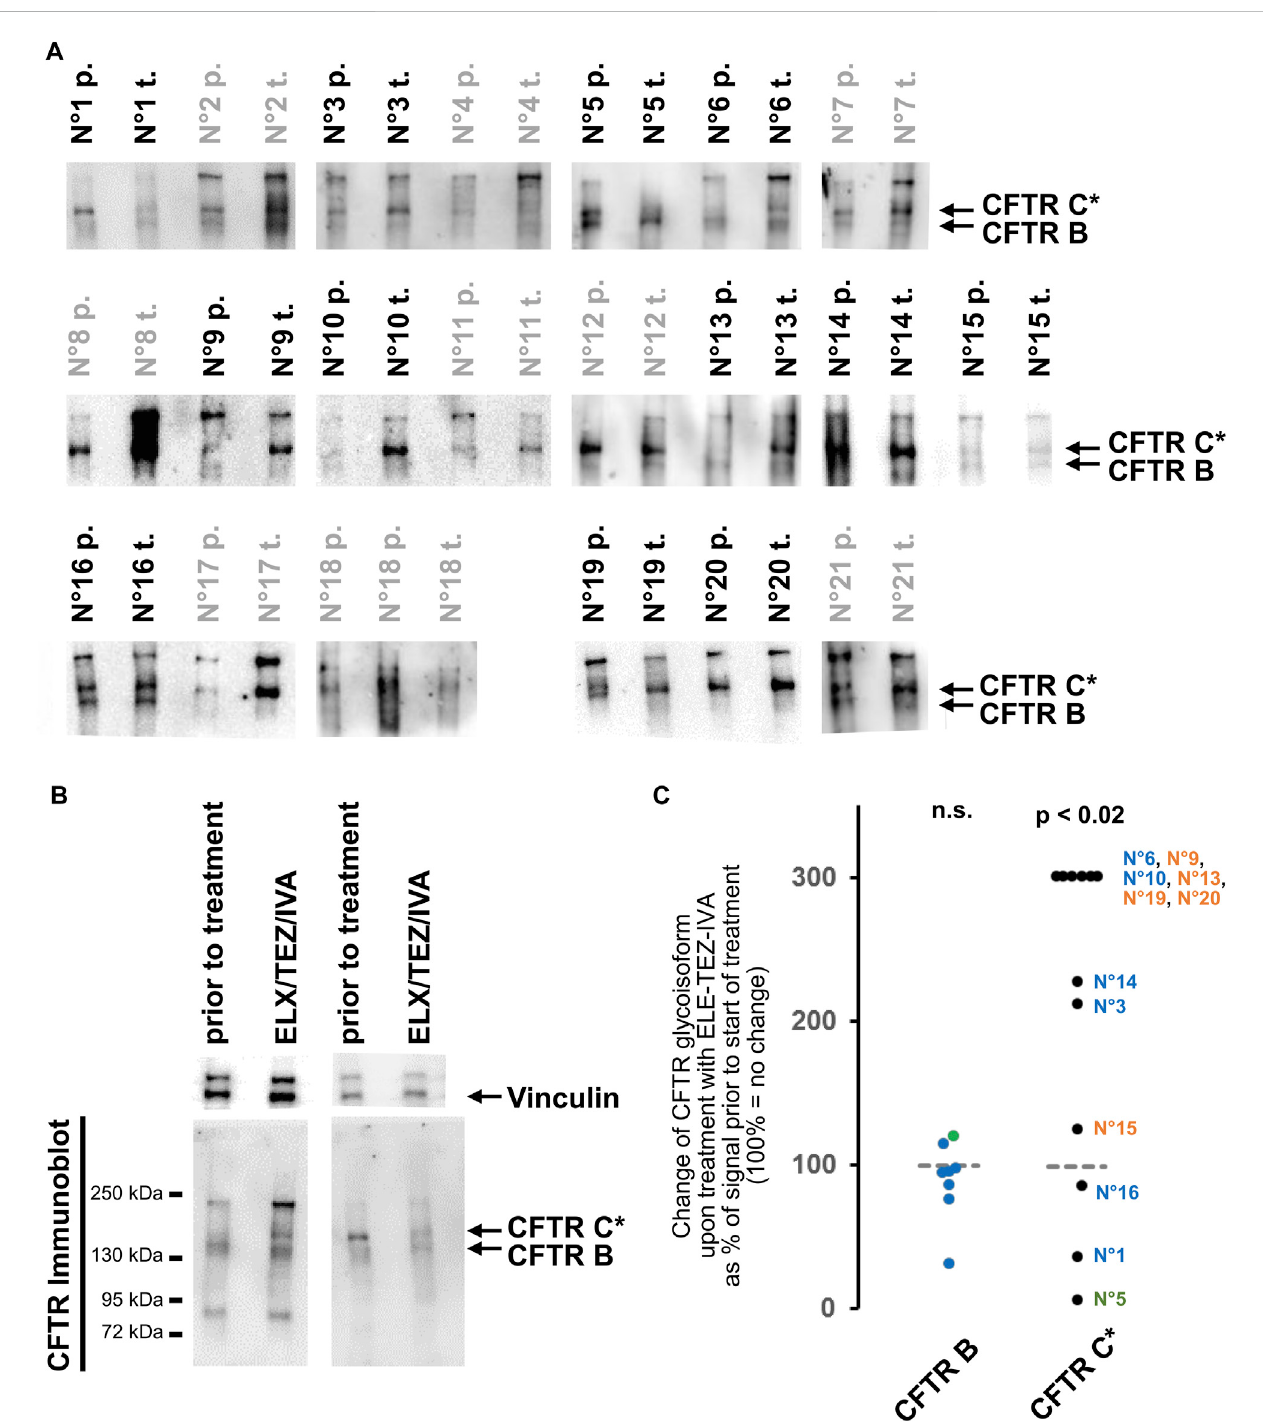
FIGURE 2 ChangesinCFTRglycoisoformsfromrectalsuctionbiopsiespriortoandafterinitiationoftreatmentwithELX/TEZ/IVA. (A) CFTRimmunoblotsignalsofrectal biopsylysatepairsfrom21patients.Samplesprior-to-treatment(labelled “ p. ” )andsamplesobtainedafterELX/TEZ/IVAtreatment(labelled “ t. ” )wereincomparable asjudgedbyCoomassiestainingandbyvinculindetectionfortheseeightpairs:N ° 2,N ° 7,N ° 8,N ° 11,N ° 12,N ° 17,N ° 18,N ° 21(labelledingrey;seemethodssectionfor detailsoncensoring).ExposuresareselectedtovisualizebandC*andBinCFsamples.CalibrationofC*vs.CFTR-Cfrom16HBE14o-isshownassourcedata of the entire patient cohort including Coomassie staining of high molecular weight proteins and vinculin signals in Supplementary Figure S2. (B) Western blot of two representative examples. Left sample pair shows an increase of CFTR C* upon treatment with ELX/TEZ/IVA (patient N ° 6) while right sample pair shows